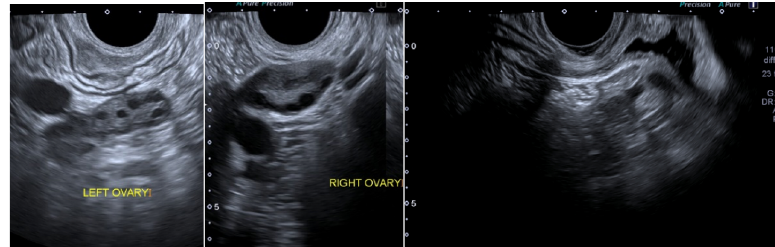
Figure 1. Trans-rectal ultrasound scan shows normal ovaries and absent uterus in case